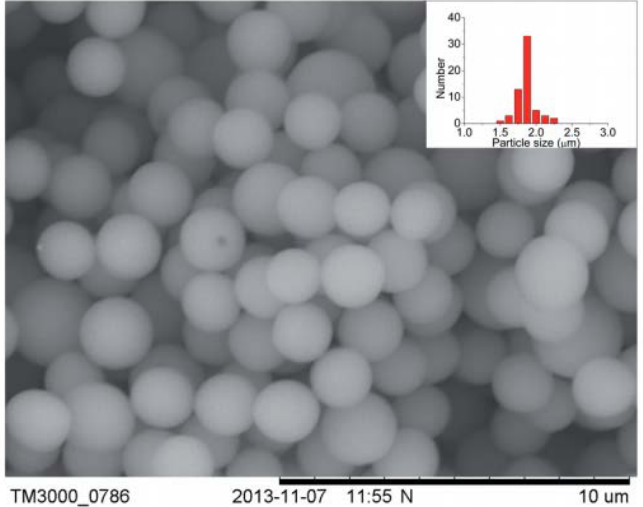
Figure 8. SEM image and size distribution (inset) of P[2-(methacryloyloxy)ethyl]trimethylammonium + bis(tri-uoromethane sulfonyl)imide − ) (P[MTMA][TFSI]) particles [112]. Copyright Royal Society of Chemistry, 2014.